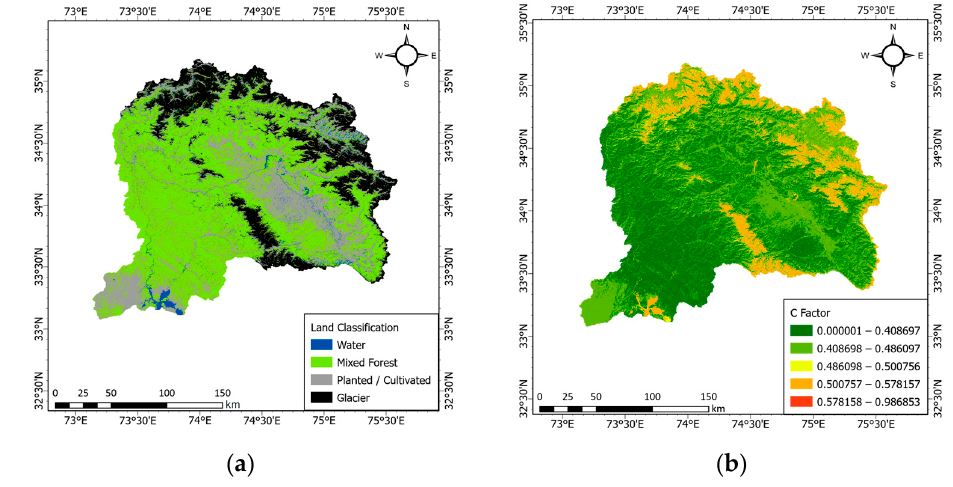
Figure 6. ( a ) Land use; ( b ) land cover management (C-factor)